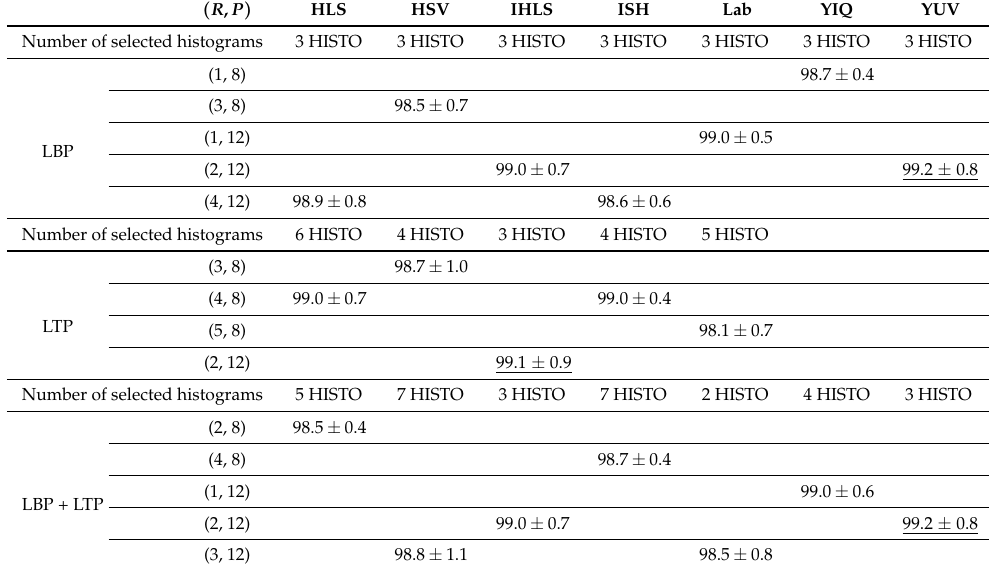
Table 2. The best results obtained for SWIMCAT dataset while using histogram selection method. Some of the best results for each color space, each feature, and the selected parameters ( R , P ) . ( R , P ) HLS HSV IHLS ISH Lab YIQ YUV Number of selected